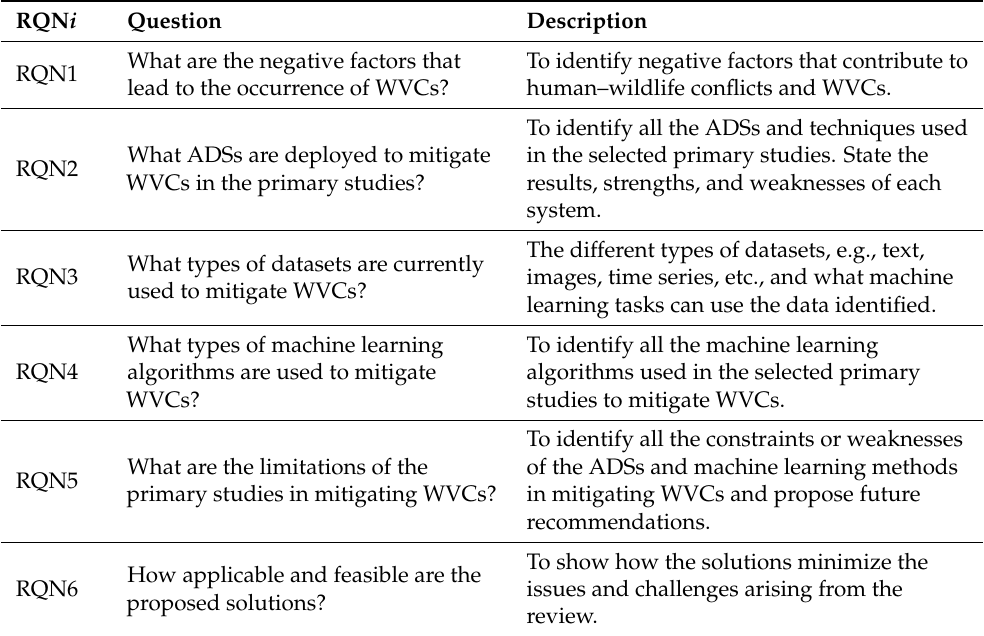
Table 1. Research questions and their descriptions. RQN i represents the research question number i